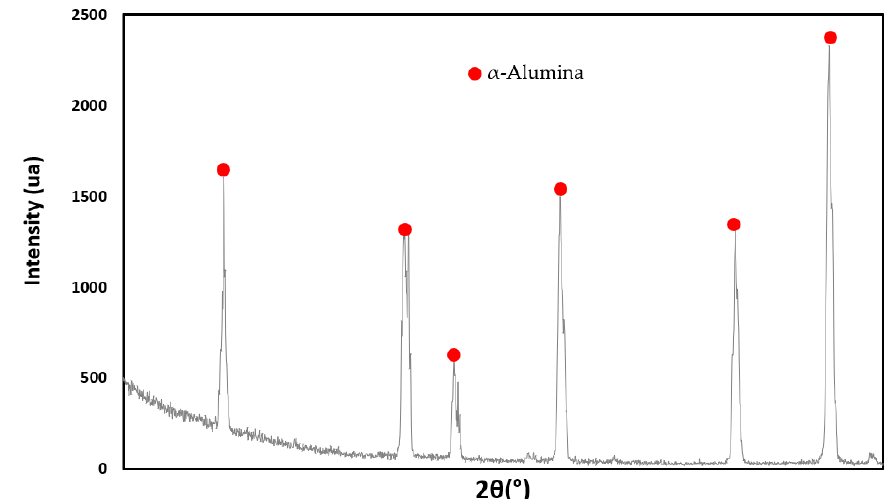
Figure 19. XRD spectra of the alumina sample manufactured by PBSLP.